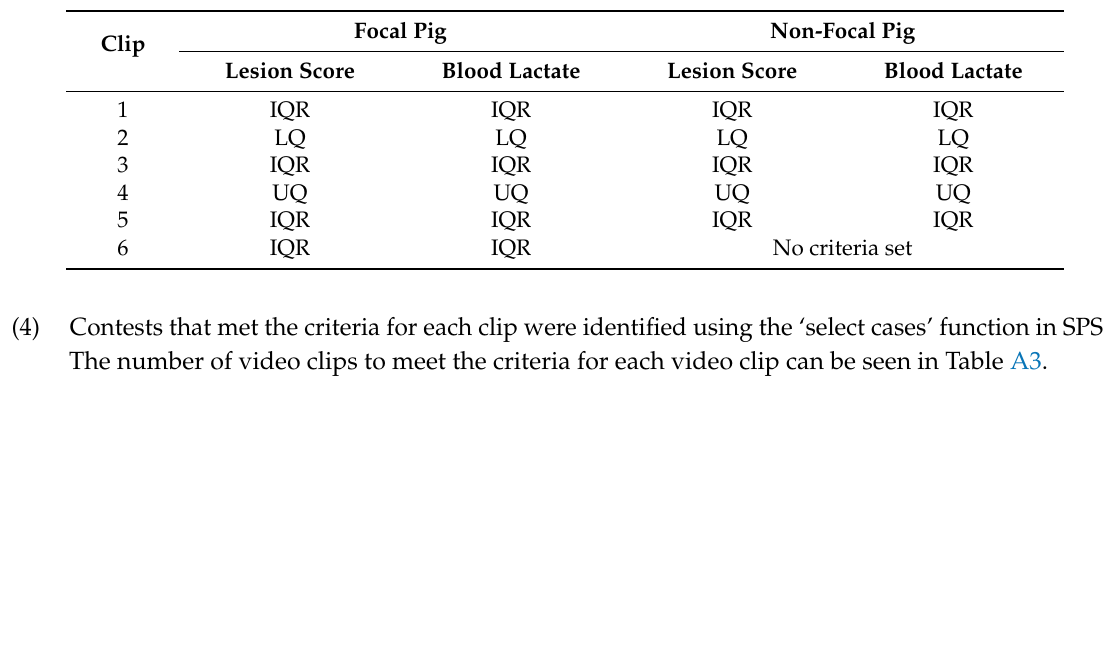
Table A2. Description of criteria used to identify video clips (LQ = lower quartile; IQR = interquartile range; UQ = upper